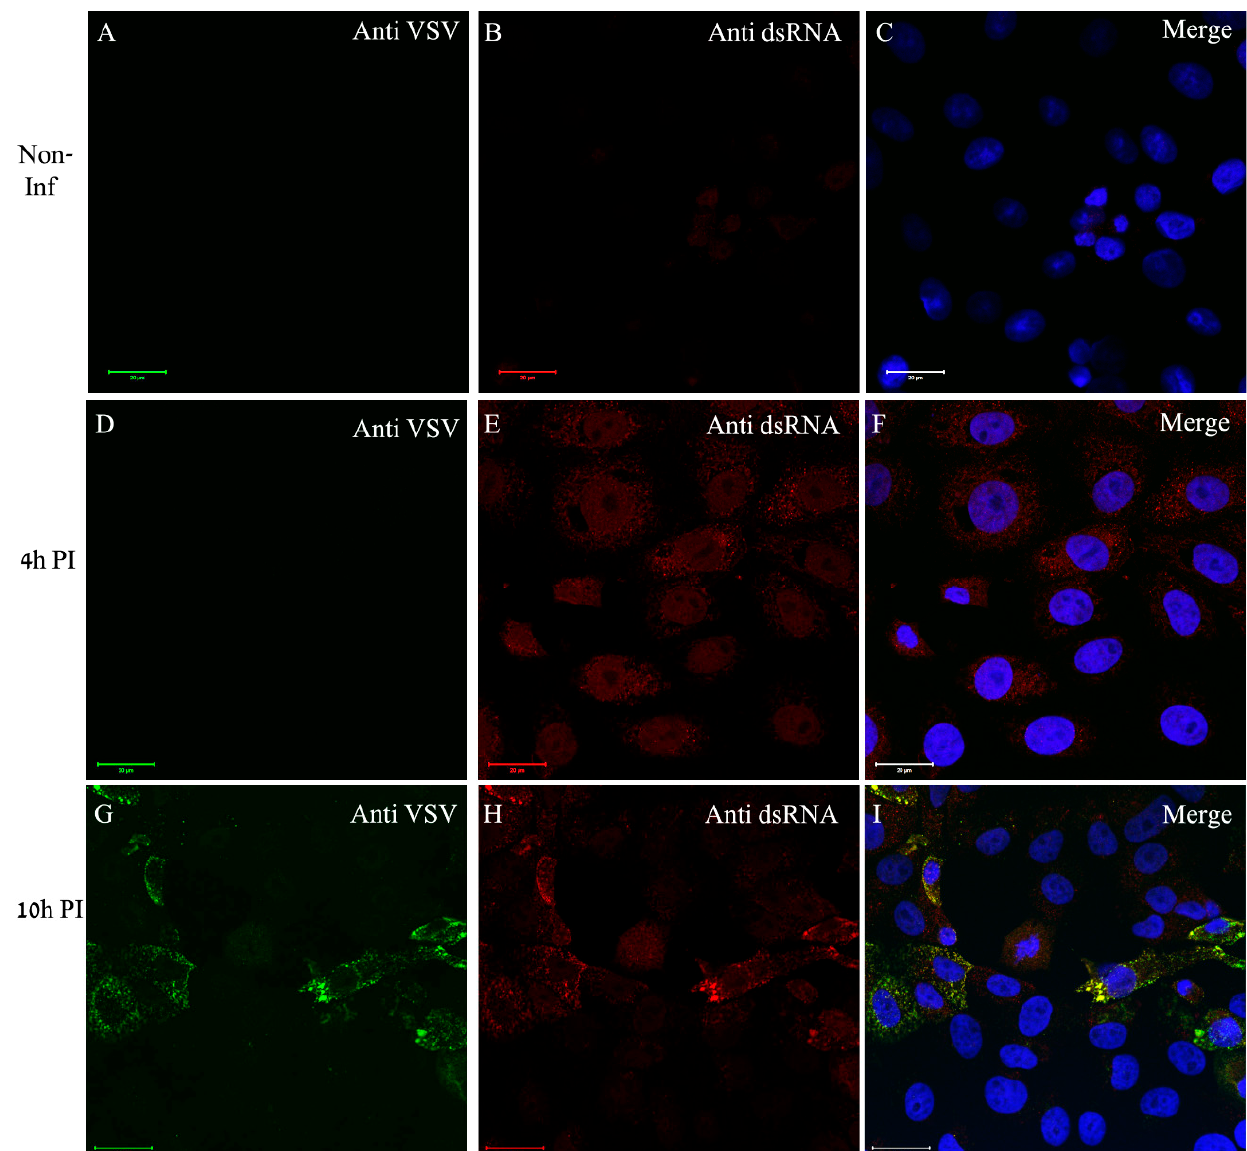
Figure 5. VSV-S genome replication occurs in discrete foci in the cytoplasm where VSV-S proteins accumulate. ( A – I ) Cells were either mock or VSV-S infected at the indicated time points and then processed by immuno-labeling with anti-VSV ( A , D , G ) and anti-dsRNA ( B , E , H ) antibodies. ( A – C ) Non-infected cells did not show any labeling of VSV proteins or dsRNA. ( D – F ) A representative image of cells infected for 4 h exhibiting no VSV proteins labeling. Scarce labeling of dsRNA in the cytoplasm is noticed. ( G – I ) At 10 h post infection, part of the cells were positive both for VSV proteins and dsRNA at distinct sites in the cytoplasm. ( C , F , I ) Merge channels of dsRNA (red), VSV proteins (green) and DAPI (blue) for nuclei staining. Scale bars are 20 µ m. Objective lens